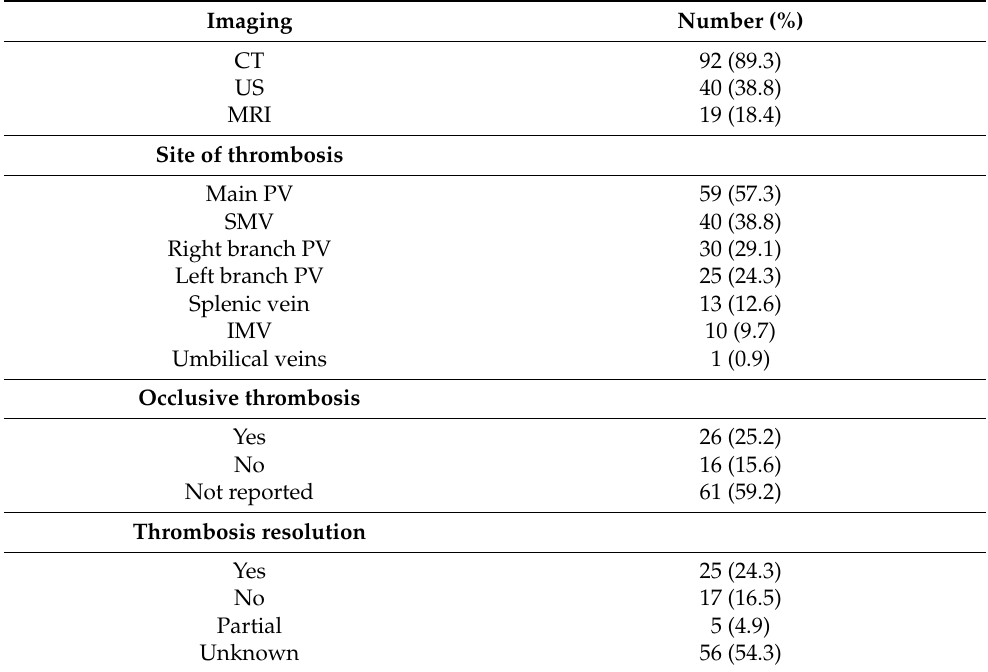
Table 2. Characteristics of thrombosis in our systematic